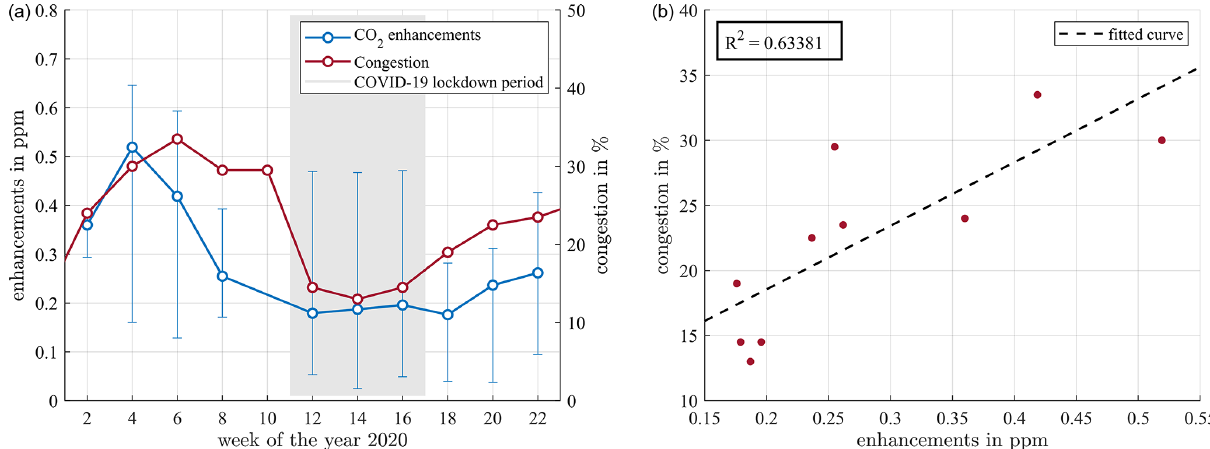
Figure 13. Correlations between the CO 2 enhancements over the background measured at our inner-city station in Munich and the traffic amount represented by the congestion rate ( a : time series; b : regression plot). The time period includes the COVID-19 lockdown in spring 2020. We show the median trend of all column concentration gradients clustered into biweekly bins. The error bars show the 1 σ standard deviation of all enhancements within the respective 2-week period. Traffic data are from © 2020 TomTom International